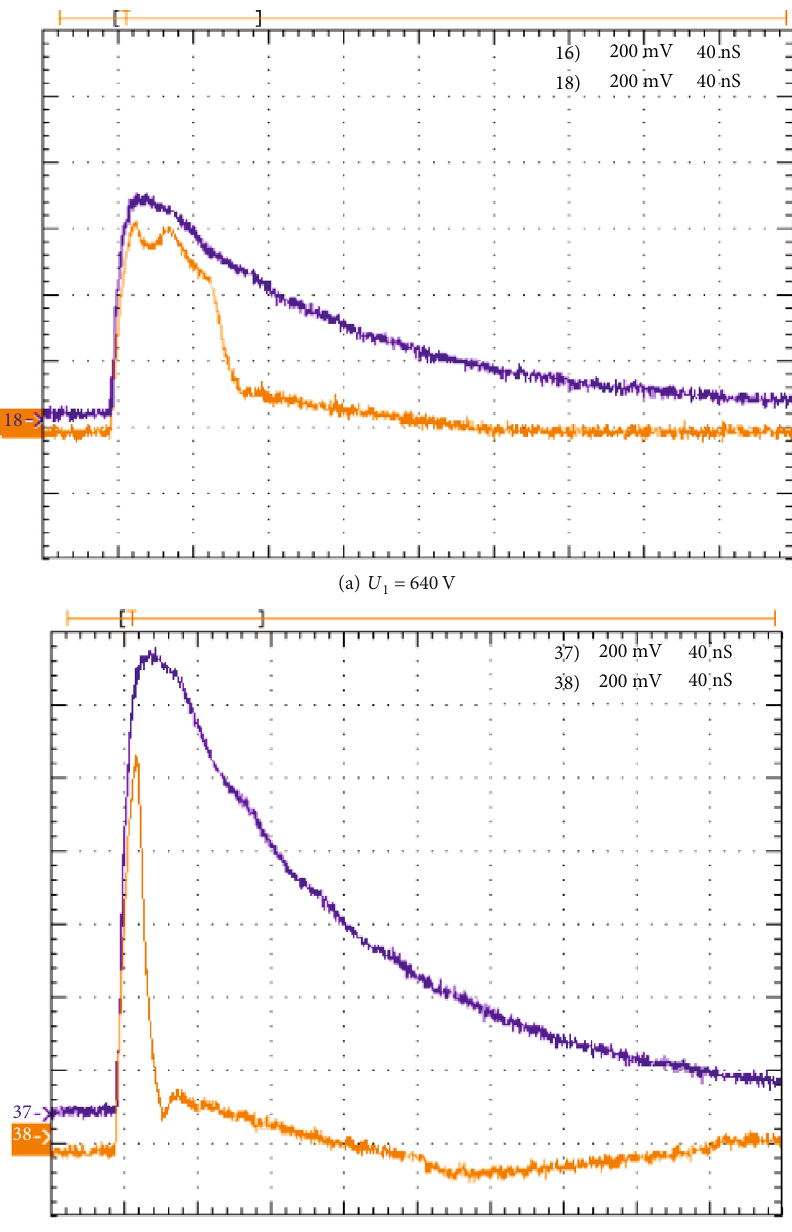
Figure 3: Response waveform of coaxial gas discharge tube to narrow pulse